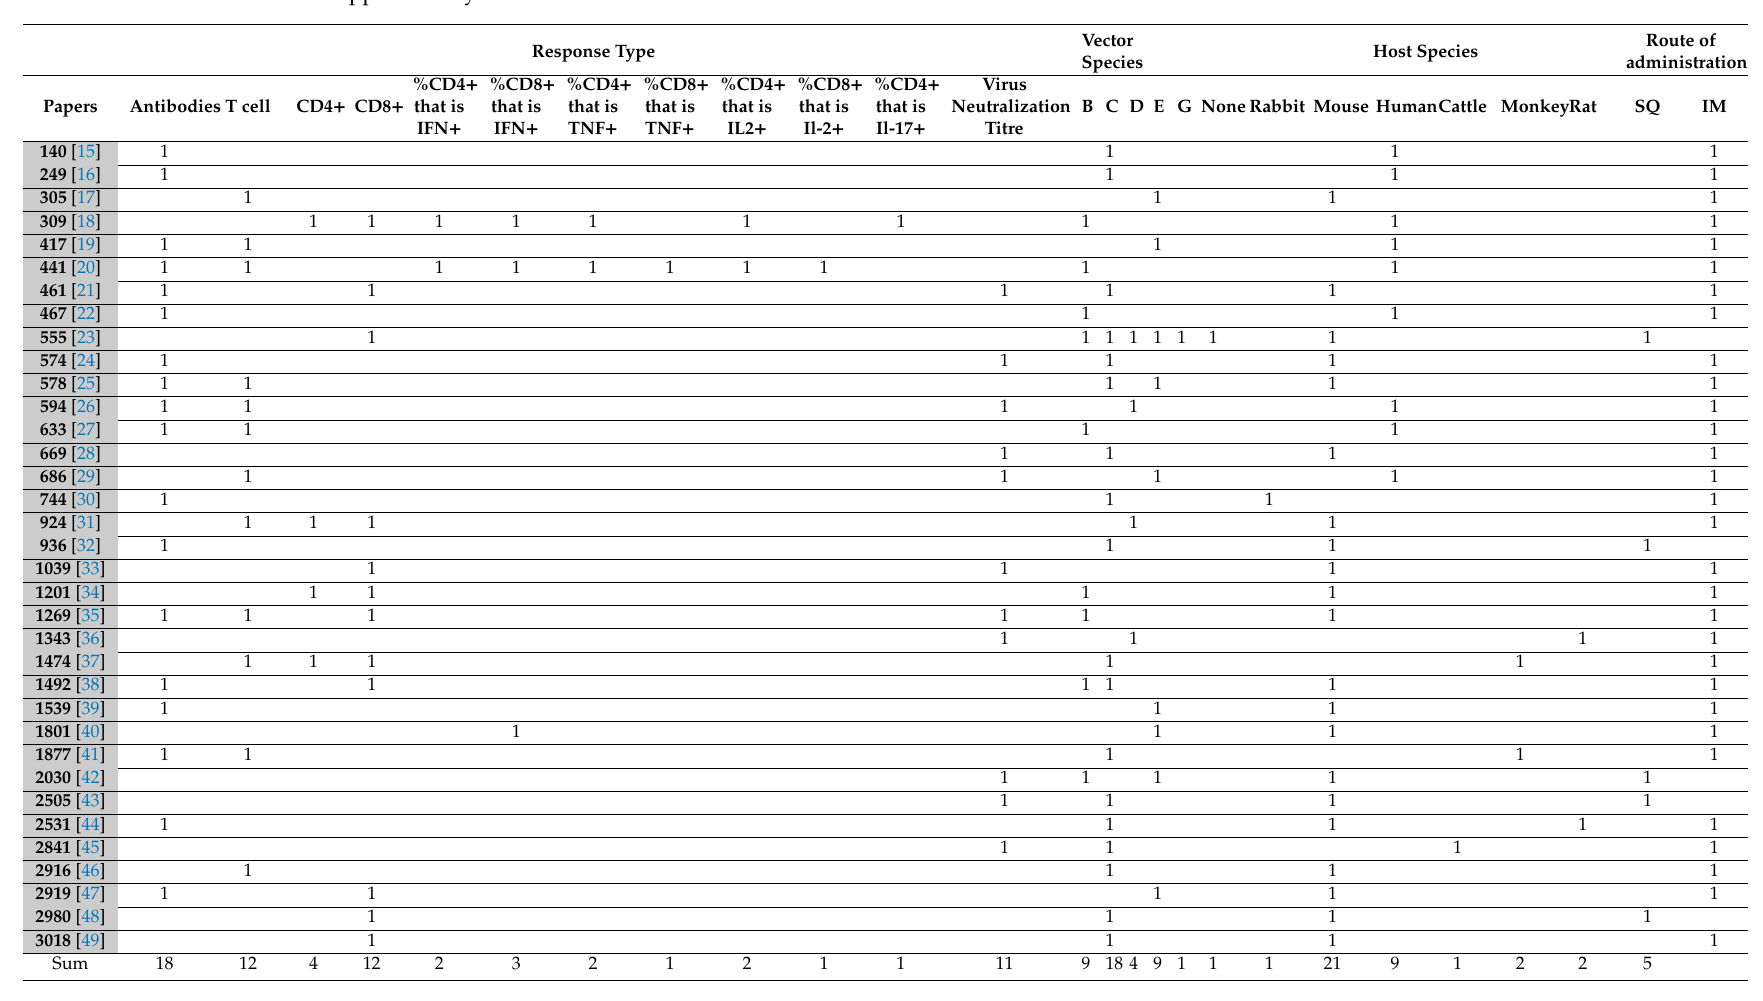
Table A1. Table of papers analysed and the respective response types, vector species, host species and RoA analysed in those papers. Also included is a reference list for adenoviral papers from which data were extracted. Papers were stored and denoted by their identification number in the bibliography software used and are referred to as such in the supplementary document of